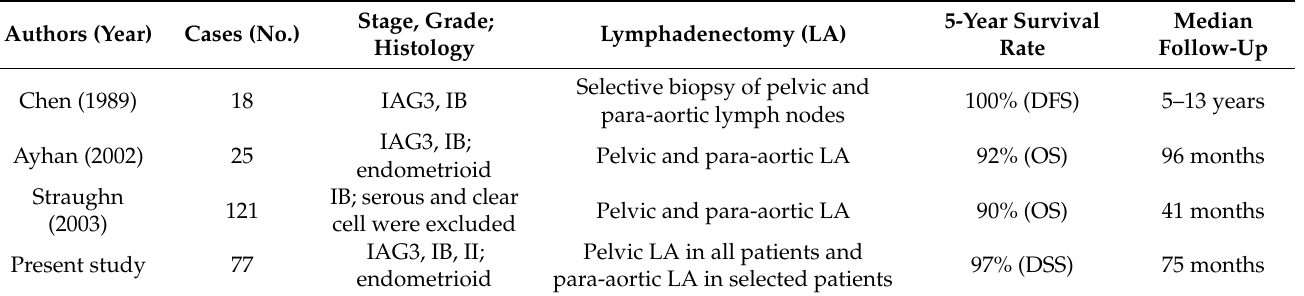
Table 3. Five-year survival rates of patients with uterine-confined intermediate- and high-risk endometrial carcinoma treated with open surgery